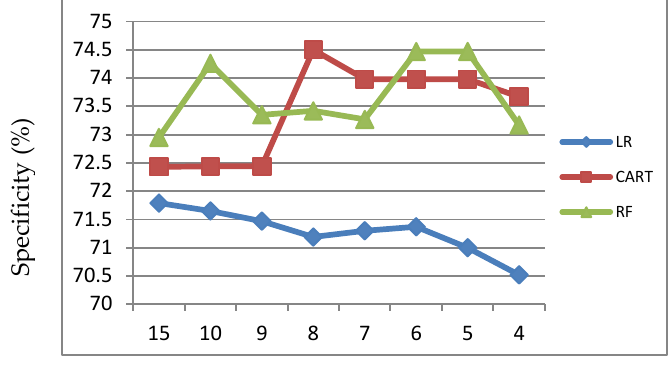
Figure 2. Sensitivity of LR, CART and RF with input of significant variables identified by LR.